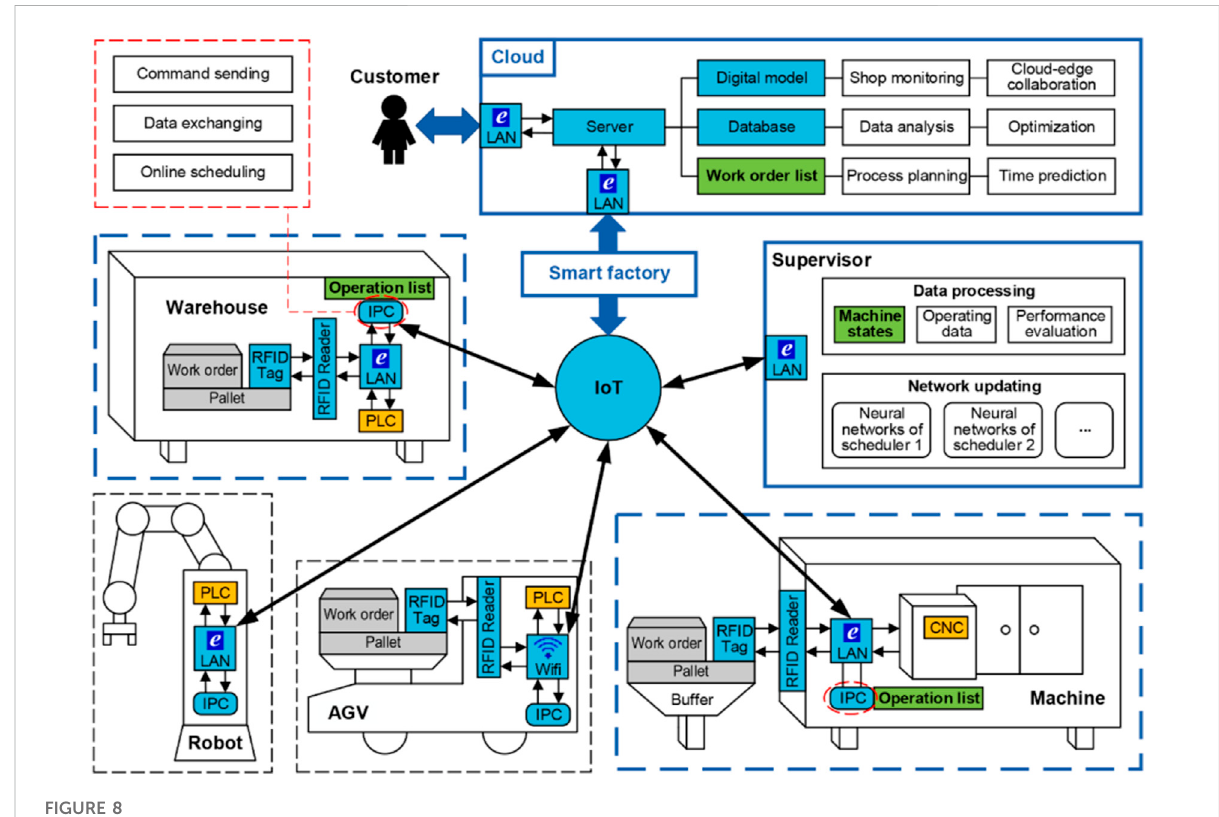
FIGURE 8 Smart factory presented in Zhou et al.